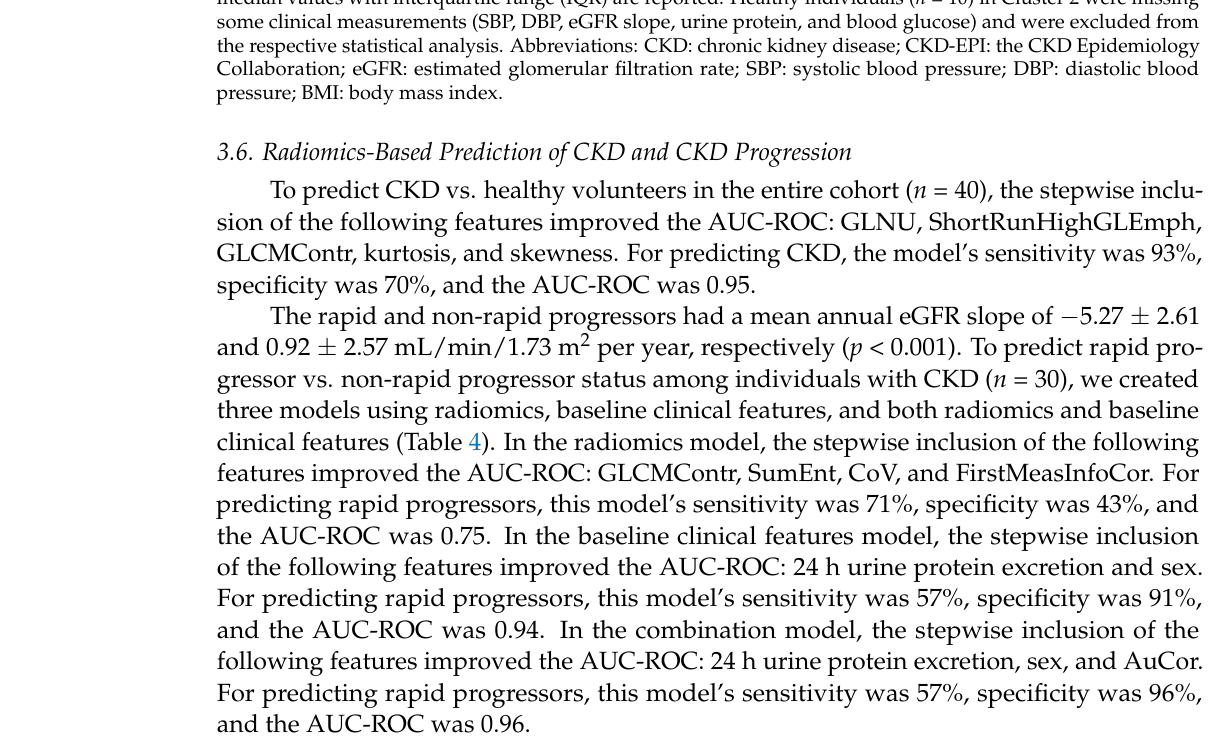
Table 4. Logistic regression models to predict rapid vs. non-rapid progressors in